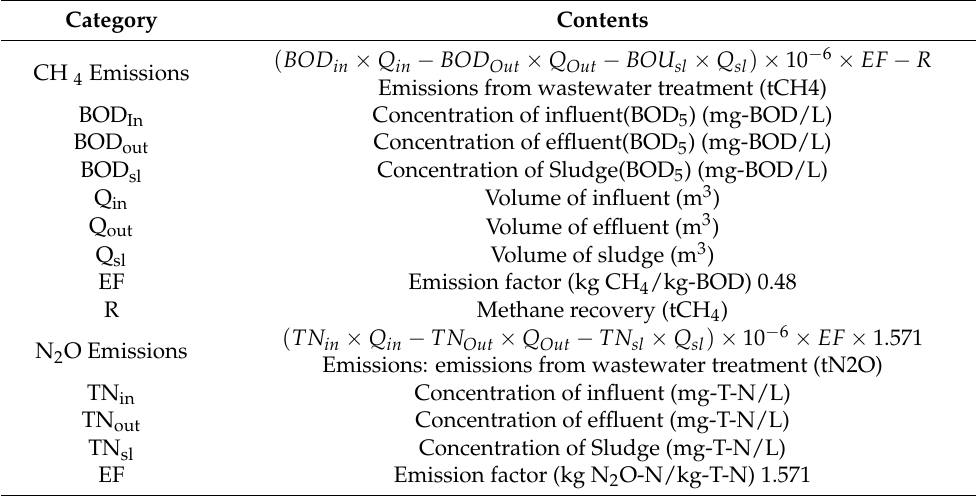
Table 2. GHG calculation formula for WWTP(Tier